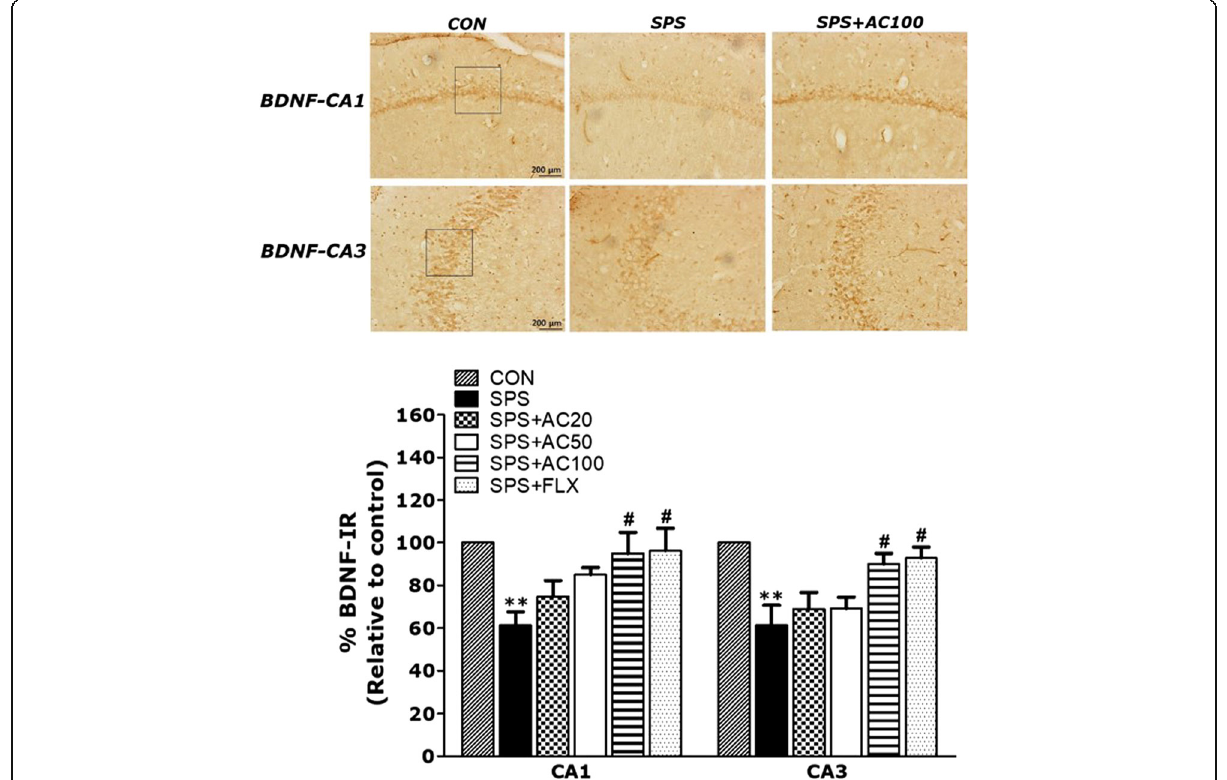
Fig. 7 Effects of AC on the mean number of BDNF-stained hippocampal areas after the MWM test. Representative photographs and relative percentages are shown. The scale bar represents 100 μ m ( n = 2~3/group). ** p < 0.01 vs. the CON group, # p < 0.05 vs. the SPS